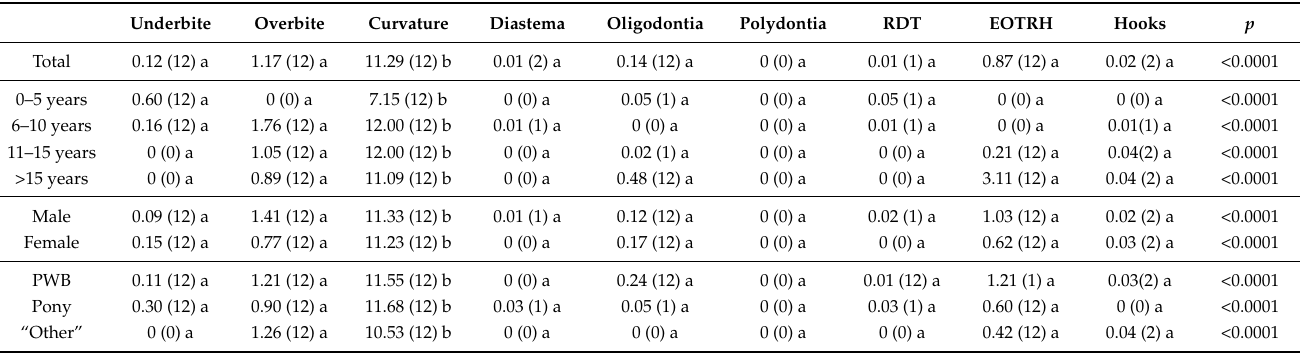
Table 5. The frequency distribution of malocclusions of incisor teeth in the total 7912 examined teeth of 206 horses.